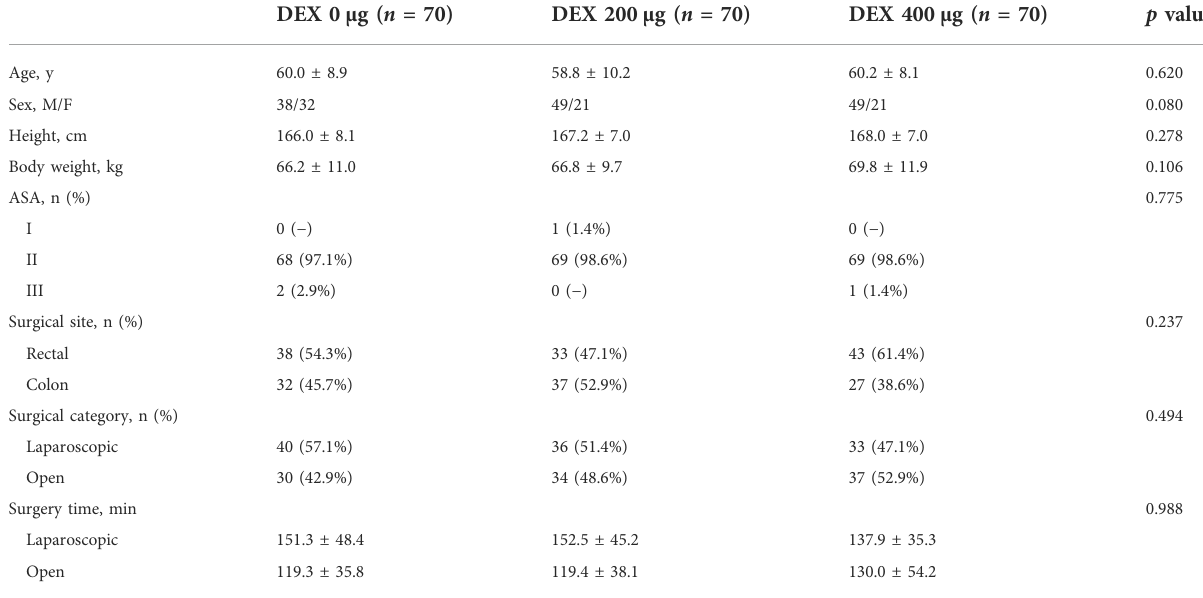
TABLE 1 Clinical characteristics of patients in the three